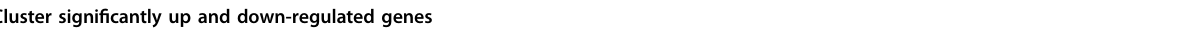
Table 1 The list of genes with most signi fi cant change upon IL-38 treatment in the co-cultured respiratory epithelial cells with macrophages.